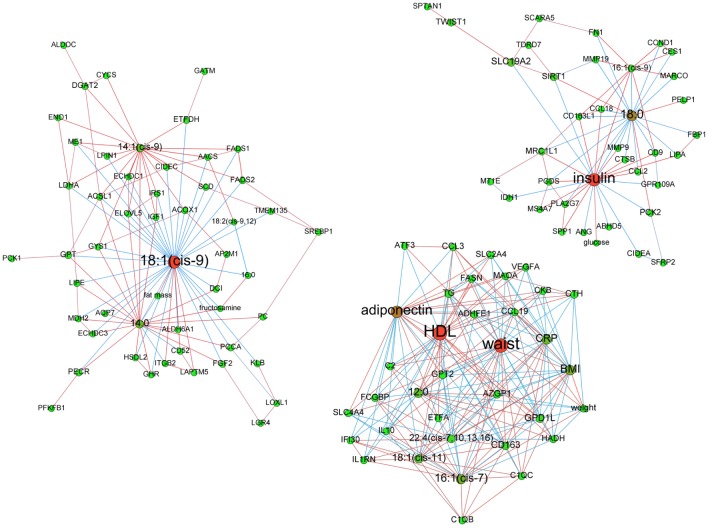
Baseline adipose tissue networks of obese women.A sparse Graphical Gaussian Model (GGM) was used to estimate partial correlations in each set of variables and regularized canonical correlation analysis (CCA) was used to assess links between paired sets of variable. Clustering was performed using a spin glass model and simulated annealing. This analysis displays the variables that are connected independently from other variables. Graphs were laid out using force-based algorithms in Gephi 0.8.2 software. Nodes’ colors and font size indicate betweenness centrality. The red nodes have the highest betweenness and the green nodes the lowest one. Edge thickness is proportional to the strength of the correlation (CCA) or of the partial correlation (GGM). Edge color indicates the correlation sign: red for positive correlations and blue for negative ones. BMI, body mass index; CRP, C reactive protein; DBP, diastolic blood pressure; HDL, high density lipoprotein; LDL, low density lipoprotein; SBP, systolic blood pressure; TG, plasma triglycerides; waist, waist circumference.